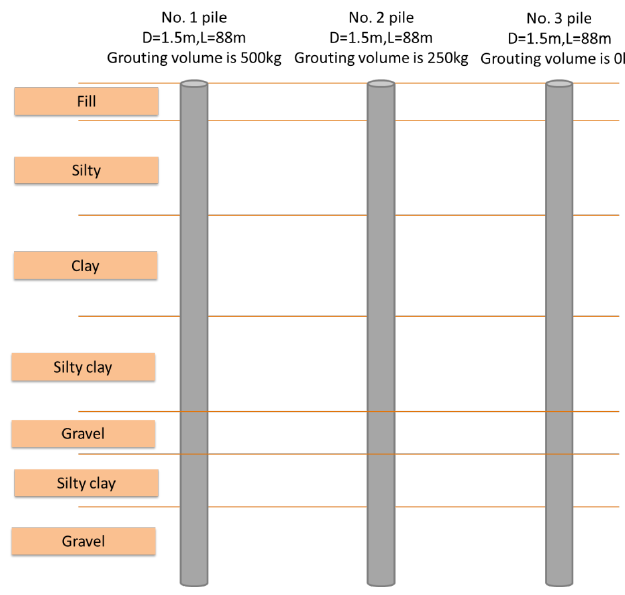
Figure 1. Site schematic diagram. Table 1. Physical and mechanical indexes of soil in the test site.